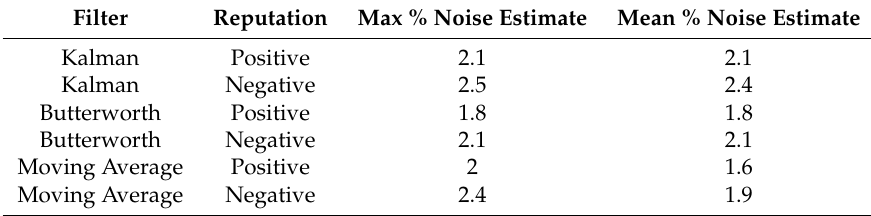
Table 5. Revised Reputation Contributions to Profit after Tax using mean and Maximum Noise